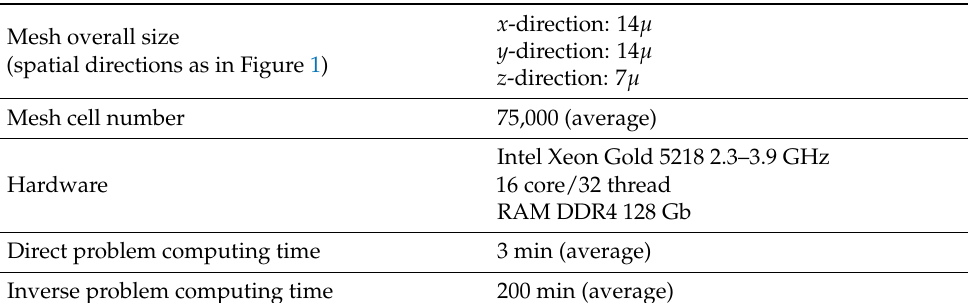
Table 1. Finite element model mesh and hardware information. Distances expressed as multiples of the thermal diffusion length µ